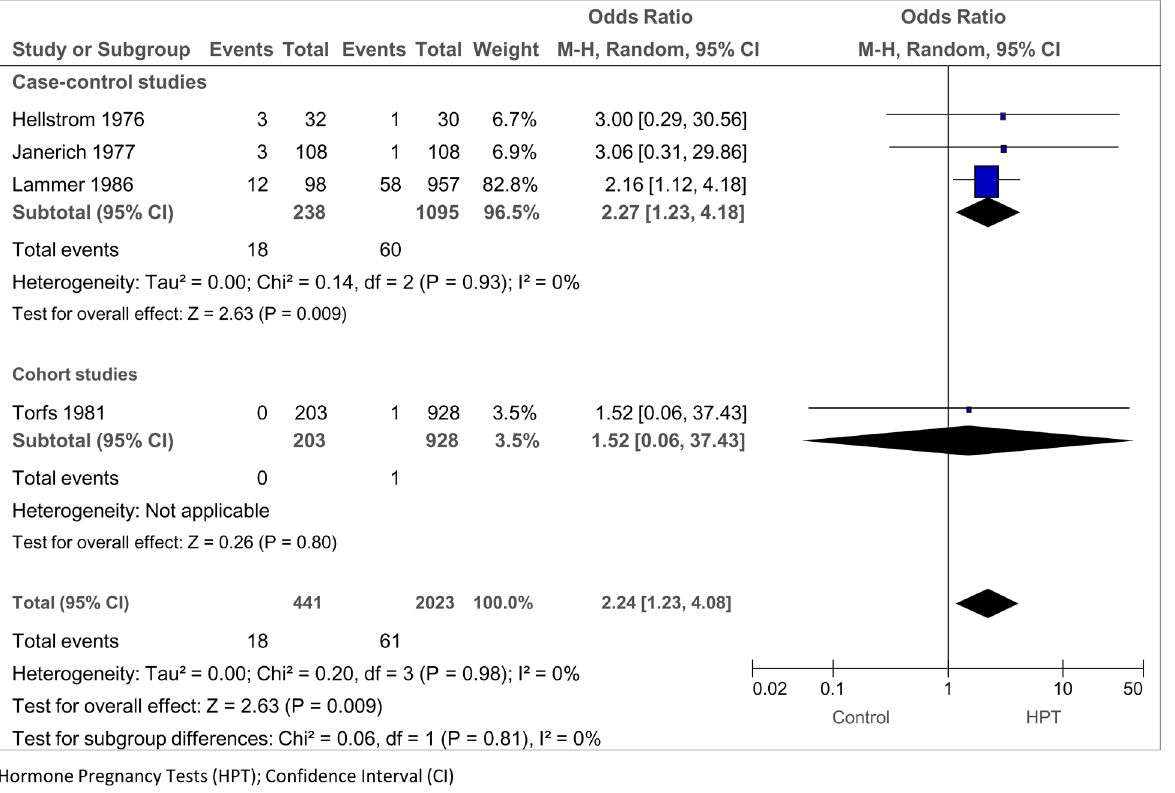
Figure 7. Association of exposure to oral hormone pregnancy tests (HPTs) in pregnancy and musculoskeletal malformations in the offspring.